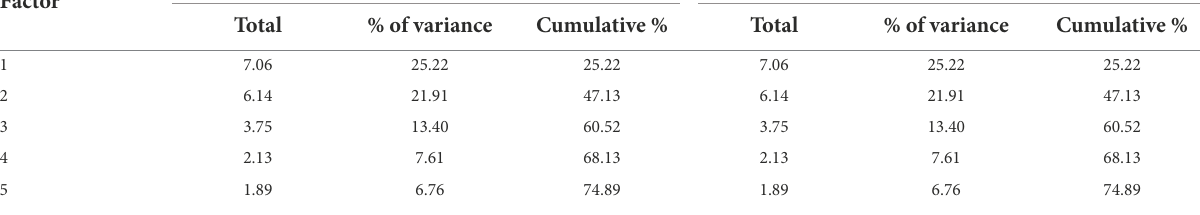
TABLE 1 Total variance explained.